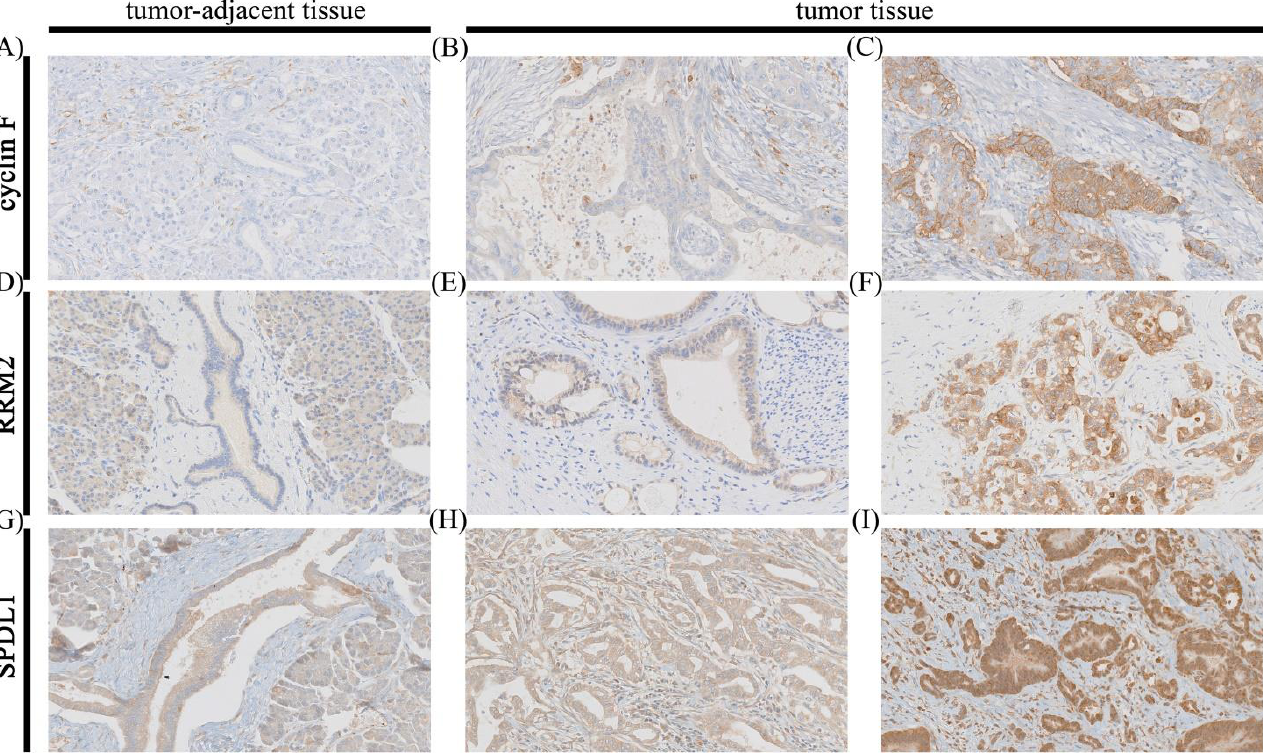
Figure 1. Representative images of immunohistochemical expression of cyclin F, RRM2, and SPDL1 in pancreatic ductal adenocarcinoma (PDAC) and adjacent tissue (control). Cyclin F staining in control ( A ); weak staining; ( B ) and strong staining; ( C ) for cyclin F in PDAC; RRM2 staining in control; ( D ); weak staining; ( E ) and strong staining; ( F ) for RRM2 in PDAC; SPDL1 staining in control; ( G ); weak staining; ( H ) and strong staining; ( I ) for SPDL1 in PDAC. Original magnification 20×.